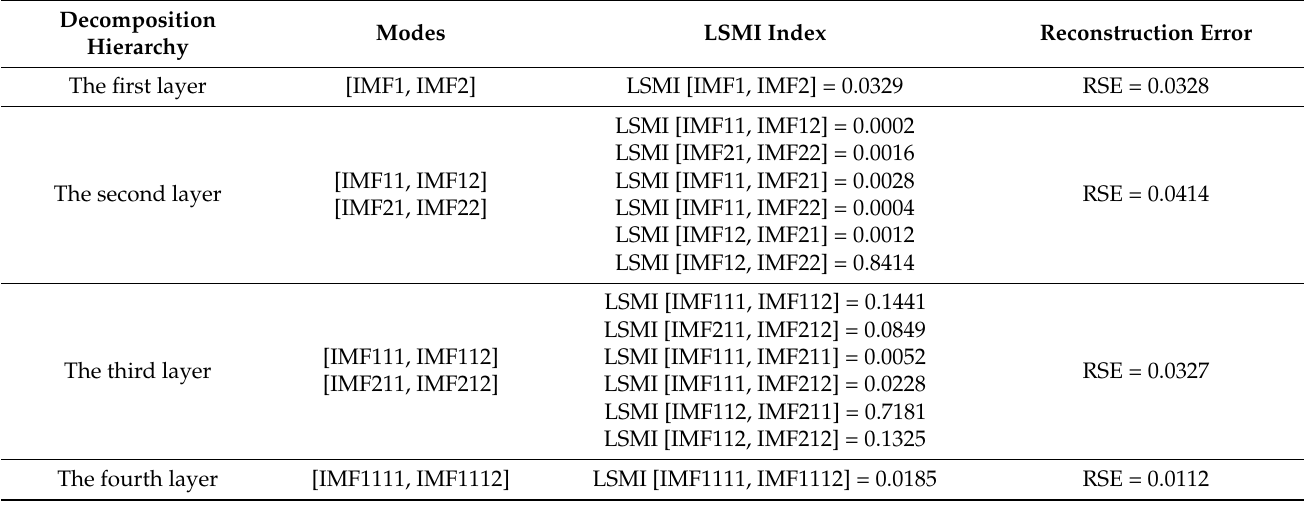
Figure 11. The fourth decomposition result. ( a ) IMF111, ( b ) IMF1111 and ( c ) IMF1112. Table 1. The LSMI and RSE obtained by BT-EVMD.